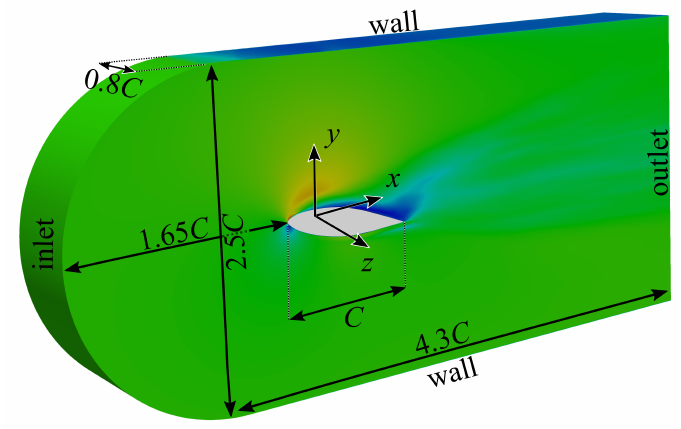
Figure 3. Overall view of computational domain, boundary conditions, and coordinate system.